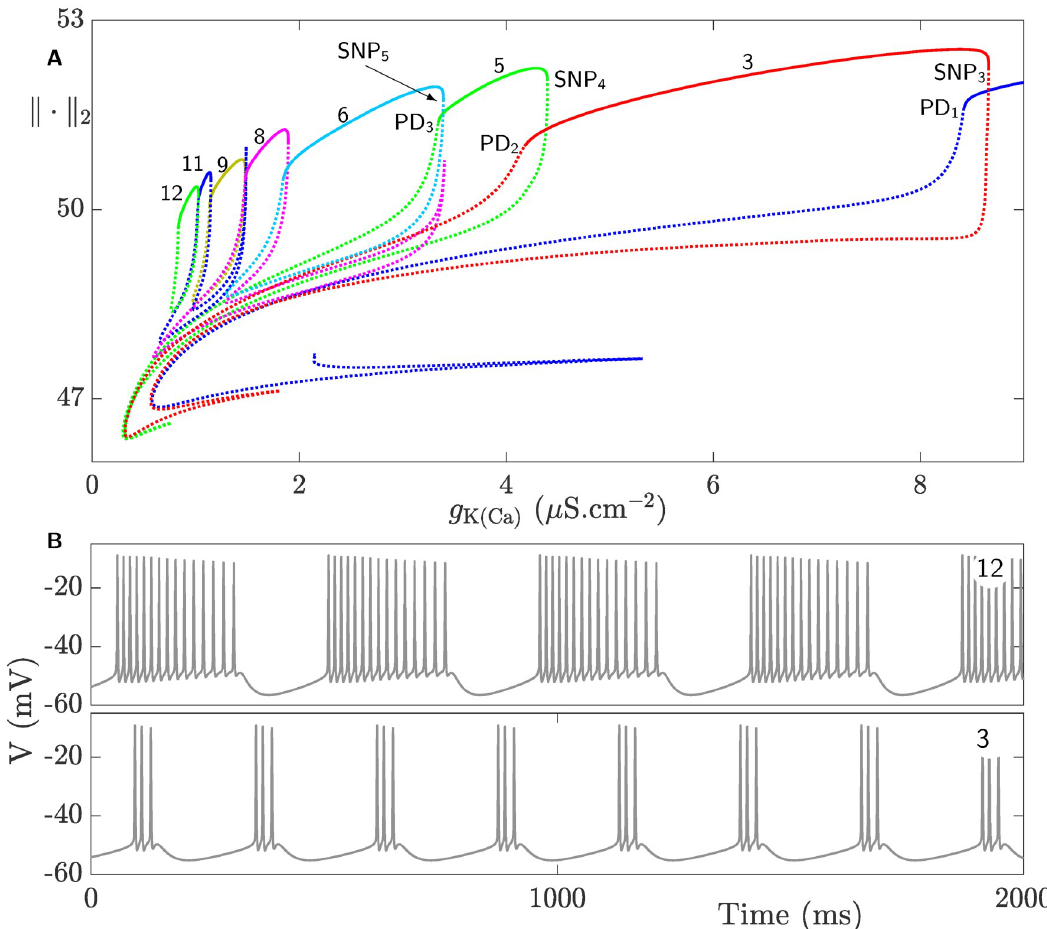
Fig 8. Square-wave bursting in the CSC model defined by the full system (1) when g K(Ca) is varied. A ) Magnification of the set of isolas of square-wave BPOs in the left black boxed region of Fig 7. The top segment of each isola is an envelope of stable periodic orbits (solid) that becomes unstable (dotted) at a saddle-node bifurcation of periodic orbits ( SNP i , i = 3, ... ) from the right and period-doubling bifurcation ( PD j , j = 1, ... ) from the left. The number of spikes for each isola is indicated by the number on top. B ) Time courses of two square-wave BPOs when the number of spikes per burst is 12 (top) and 3 (bottom) obtained at g K(Ca) = 0.9 μ S. cm − 2 and g HVA = 6 μ S.cm − 2 ,